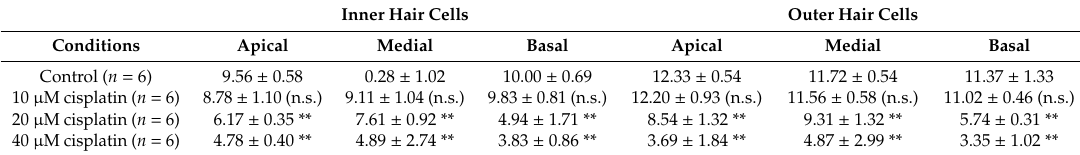
Table 2. Influence of cisplatin on the hair cell loss. Shown are the average numbers of intact inner and outer hair cells per 100 µm in the apical, medial, and basal parts of the explants. Significant differences compared to the control sample were calculated with one-way ANOVA; significance ** p < 0.01; n.s.— not significant.